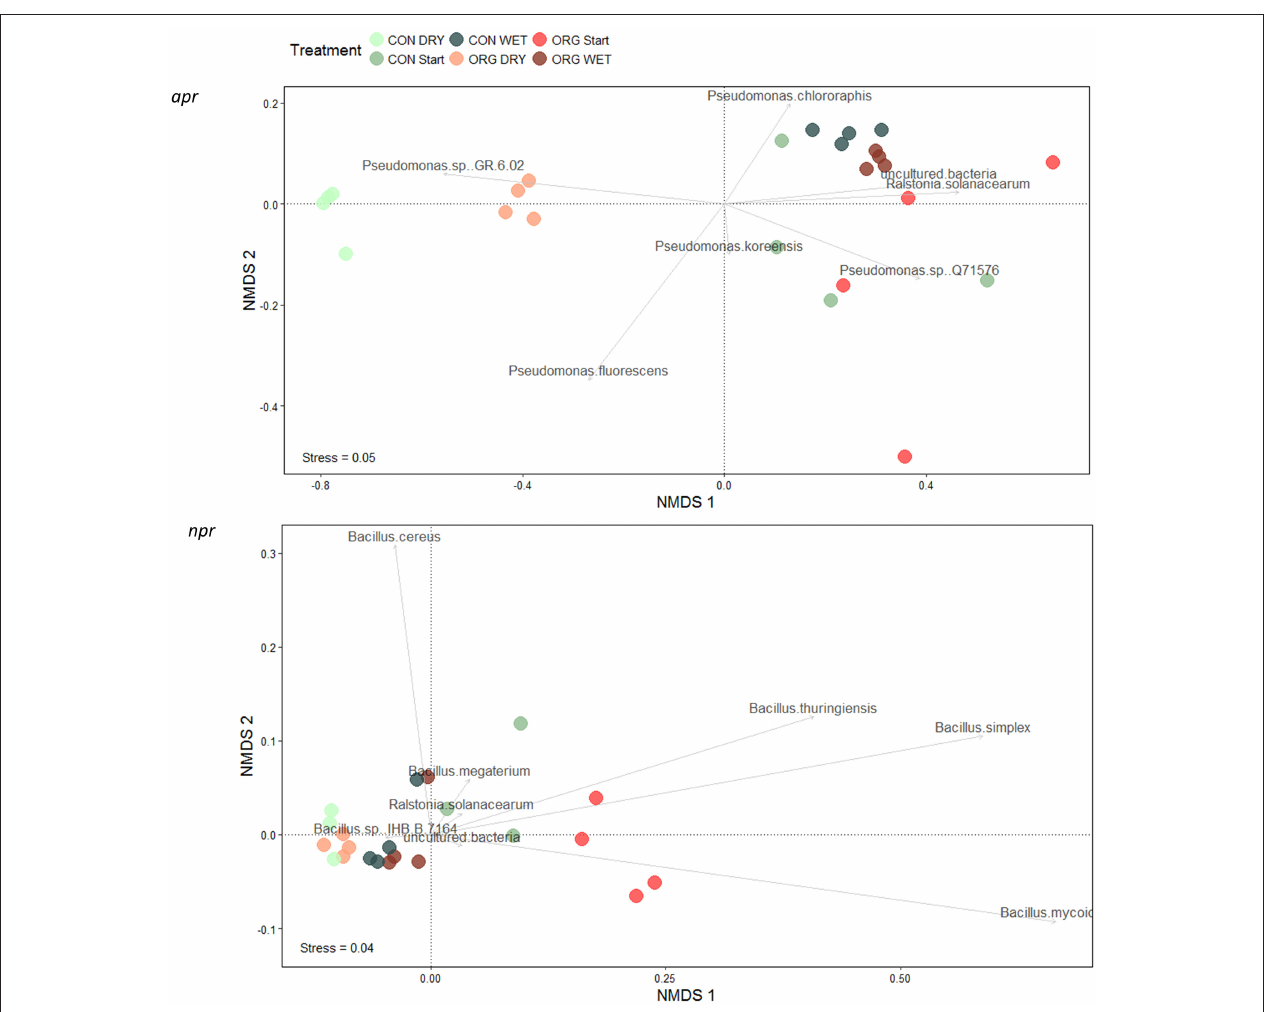
FIGURE 3 | Nonmetric multidimensional scaling (NMDS) ordination of alkaline metallopeptidase ( apr ) and neutral metallopeptidase ( npr ) encoding microbial communities based on Bray-Curtis distance metrics (incubation experiment). Treatments are labeled according to the legend with conventional (CON), organic (ORG) and the respective water treatments DRY and WET. Vectors indicate species (organisms carrying the respective sequence annotated to a species) being most influential for the differentiation between treatments (identified via SIMPER analysis).